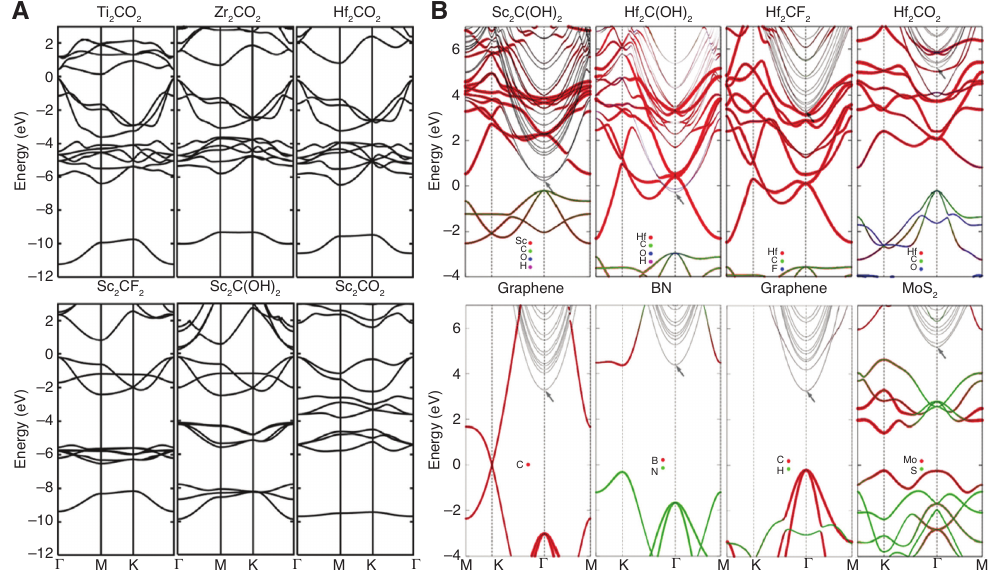
Figure 4: The band structures for six MXenes and for the constituent atoms in the systems in [42]. (A) Band structure of six semiconducting MXenes with M CT structures. The Fermi energy is at zero. This image revealed the significant 2 2 influence of M element and T surface group to the band structure of MXenes. Adapted with permission from [67], Wiley-VCH Verlag GmbH & Co. KGaA, Weinheim. (B) Projected band structures on each constituent atoms for eight different systems indicated in the figures. The position of the lowest NFE near the Fermi energy at the G point is indicated by an arrow. The Fermi energy is located at zero energy. Adapted with permission from [70], The Royal Society of Chemistry.